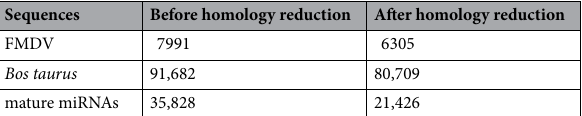
Table 1. Nucleotide sequence data before and after homology